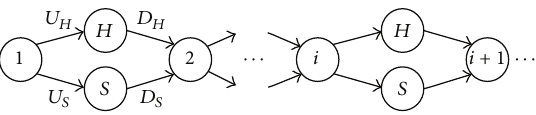
Figure 1: Markov interpretation of the VM execution